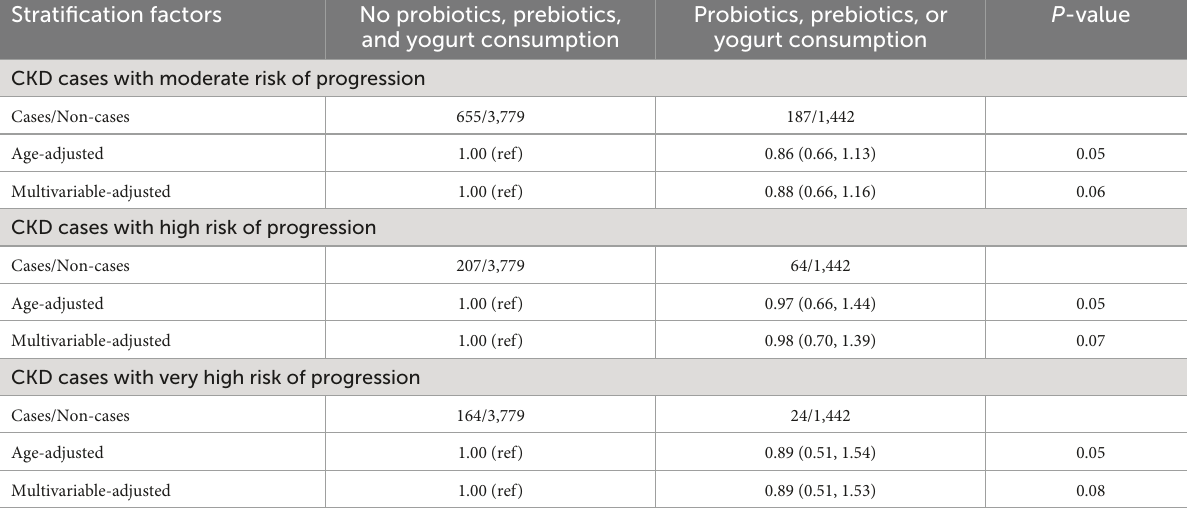
TABLE 4 Multivariable-adjusted odds ratio (95% confidence intervals) of chronic kidney disease (CKD) subtypes defined by its risk of progression by use of nutrition labels. Stratification